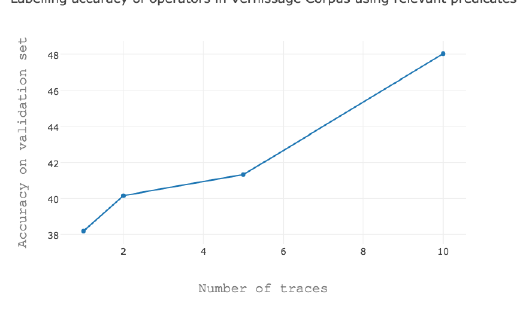
Figure 9: LSTM operator labeling accuracy with relevant predicates as constituents of the feature vector (128 hidden units, 0.8 dropout